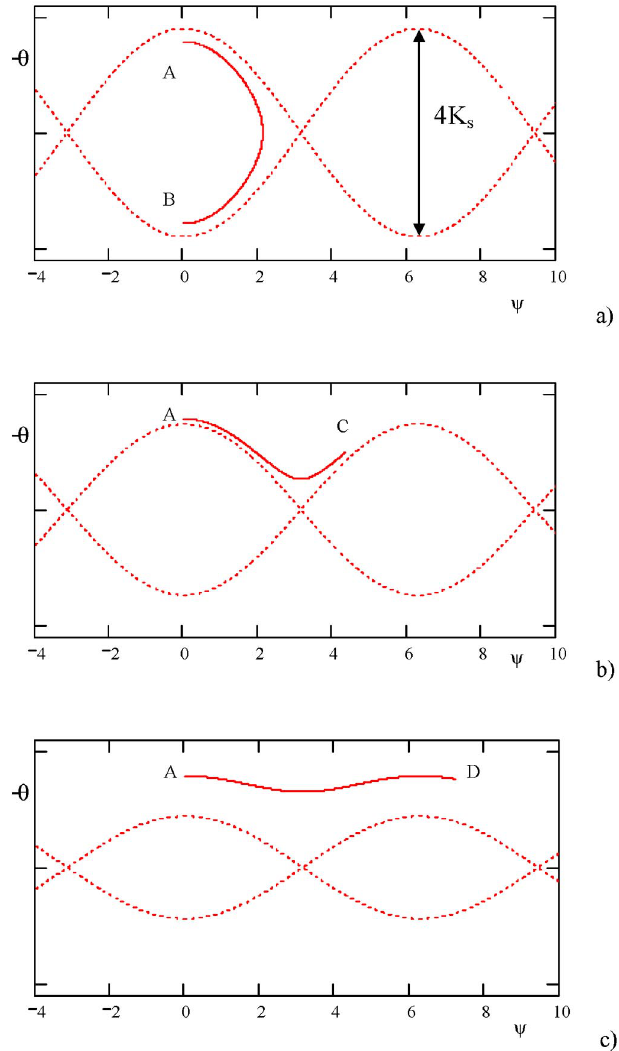
FIG. 9. (Color) Closed (a) and open (b),(c) electron saturation trajectories in the prebunched beam FEL oscillator in different stored circulating power conditions (different values of K all cases the electron starts at point A : 2 (cid:3) 0 (cid:4) (cid:1) 0 . In (a)